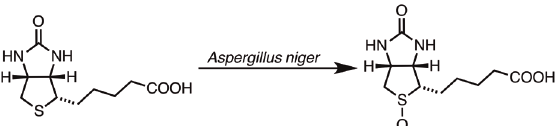
Figure 4 - Biotin-l-sulfoxide formation from the fermentation using A. niger (Wright et al. 1954b).